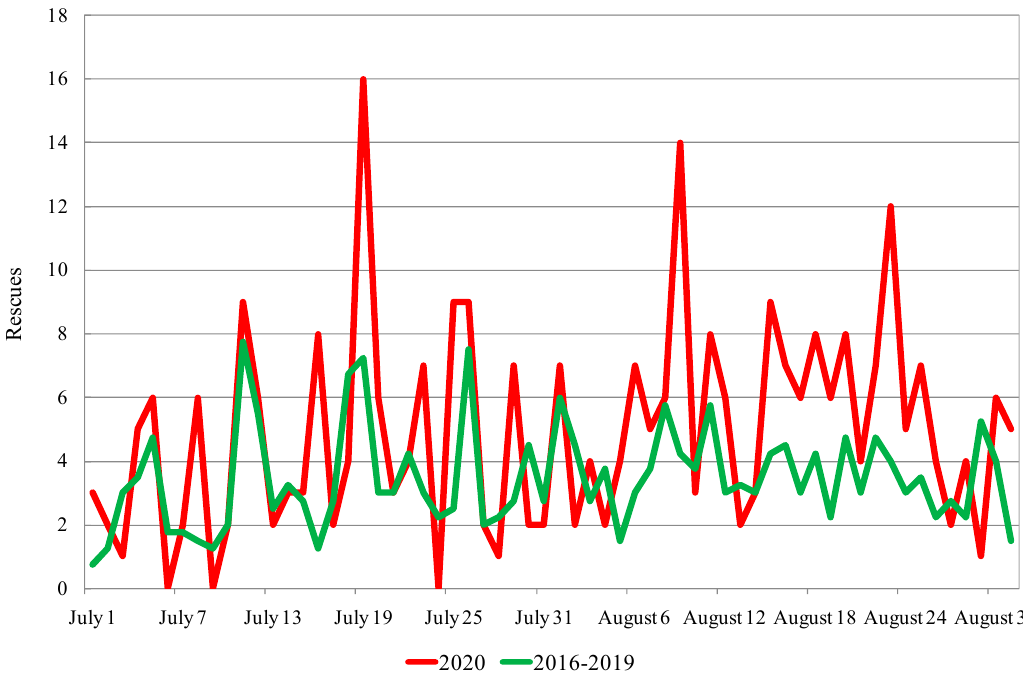
Figure 2. Daily distribution of rescues from 1 July to 31 August 2020 and equivalent period for 2016–2019.